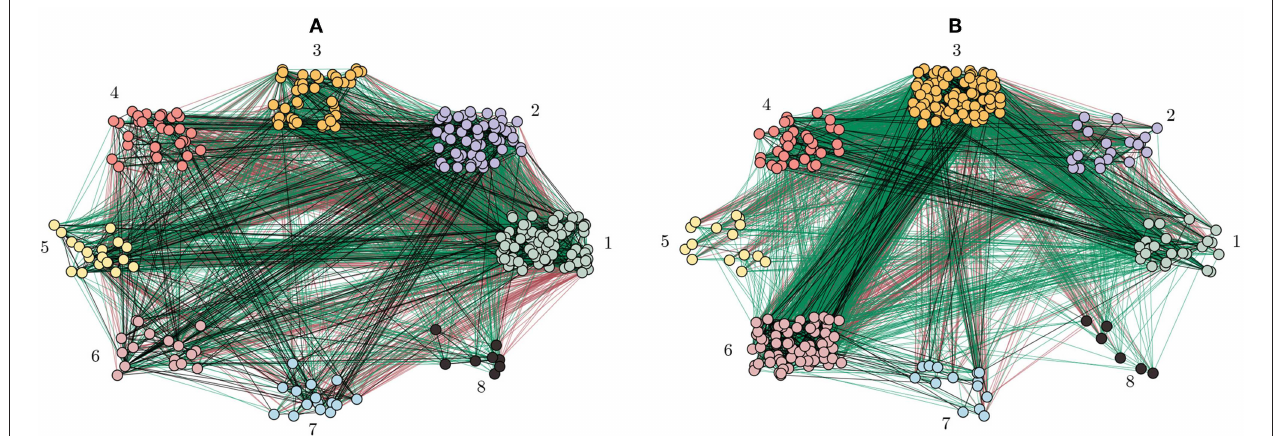
FIGURE 11 | Community partitions of the biological C. elegans network. (A) The network is divided into 8 communities of different size using the Multilayer-Louvain algorithm (see Methods 5.4). Neurons are colored according to their community as in Figure 5 . (B) The same network is partitioned using the correlation matrix approach (see Methods 5.5). Refer to Figure 8 for community